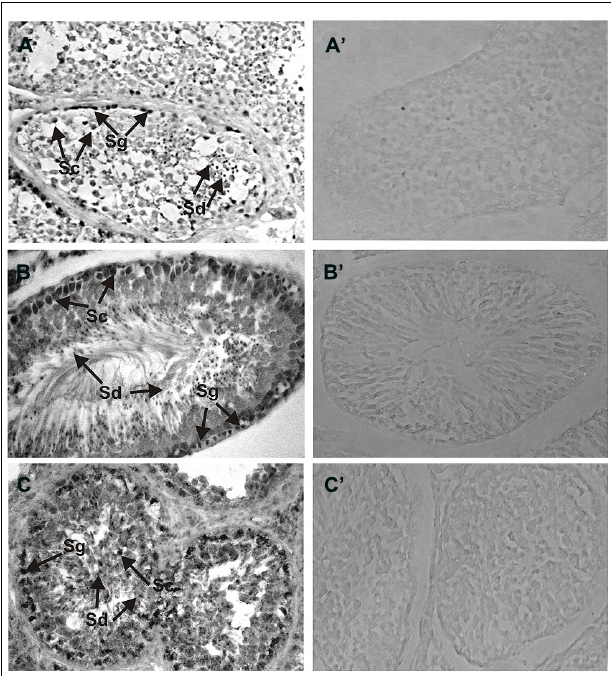
FIGURE 2 | Immunolocalization of ROS-GC1 in the testes. Immunohistochemistry was performed using specific antibodies against ROS-GC1 on paraffin sections of human (A) , rat (B) , and bovine (C) testes. The ROS-GC1 was localized in spermatogenic cells. In the testes positive staining was observed in spermatogonias (Sg), spermatocytes (Sc) and spermatids (Sd), as indicated by the arrows. Control staining was performed according to the procedure for ROS-GC1 detection, except that preimmune serum was used instead of the primary antibody (A’–C’) . Original magnification 400X.